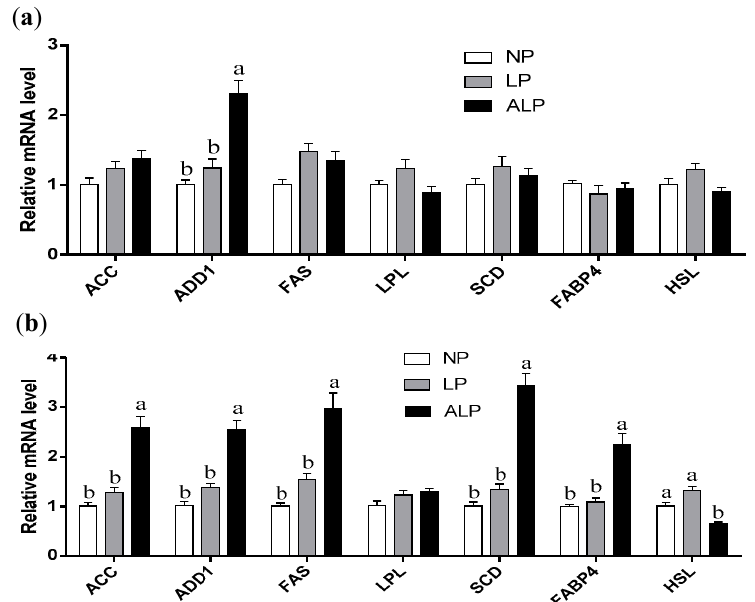
Figure 2. E ff ects of dietary AKG supplementation of a low-protein diet on the relative mRNA expression levels of genes in the longissimus dorsi muscle ( a ) and biceps femoris muscle ( b ) of the growing pigs. Results are means ± SEM, representing nine animals per treatment. Bars without a common letter differ significantly ( p < 0.05). NP, normal protein; LP, low crude protein; ALP, AKG + low crude protein.